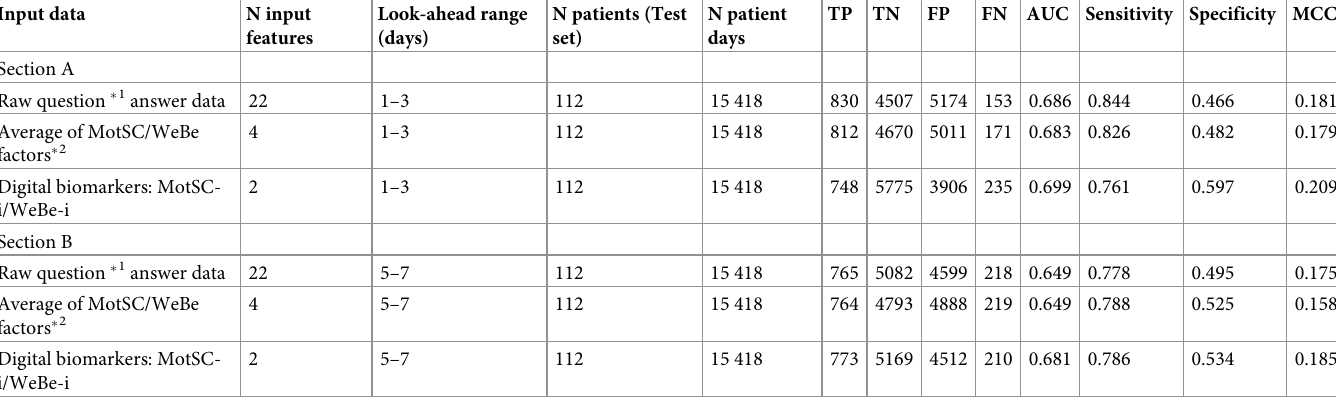
Table 5. The performance of the LSTM neural network model’s capability to predict exacerbation events (EE) of unseen patients from the Test dataset. True Posi- tives (TP), True Negatives (TN), False Positives (FP), False Negatives (FN), Sensitivity, Specificity and Matthews Correlation Coefficient (MCC) were calculated using the threshold that yielded the maximum MCC. Section A refers to predicting EEs occurring 1–3 days in the future, and section B refers to predicting EEs occurring 5–7 days in the